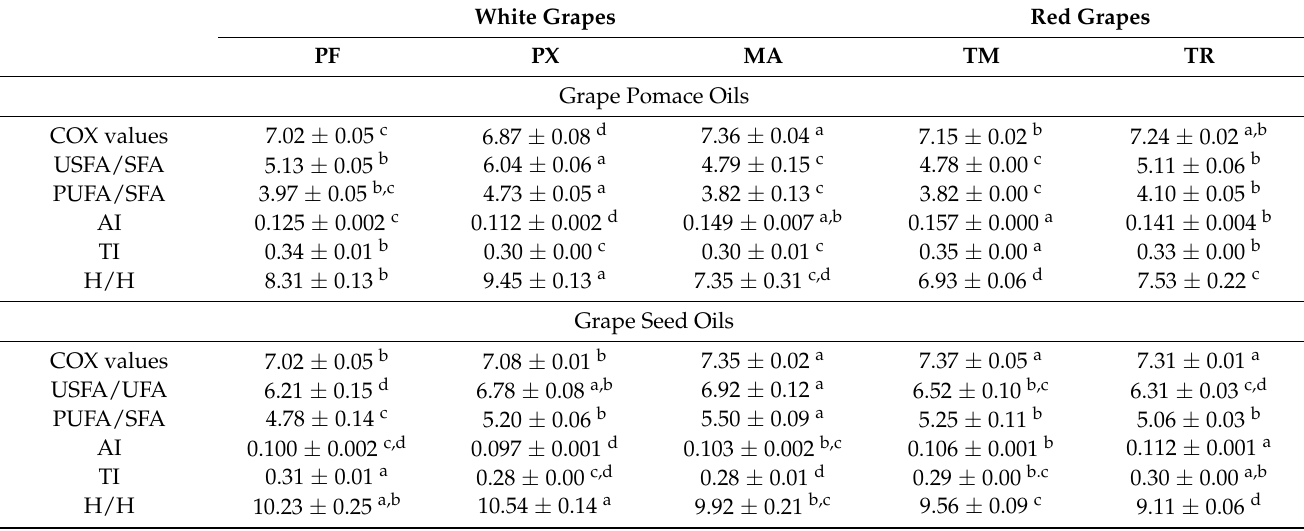
Table 3. Indicator of nutritional quality of grape oils. White Grapes Red